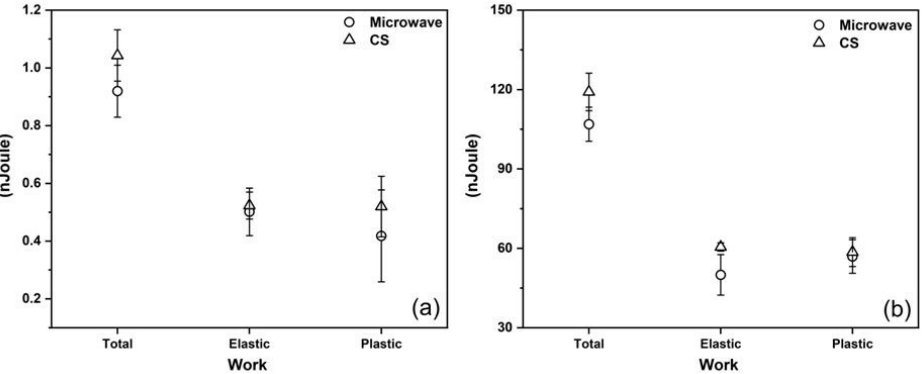
Figure 8. Total, elastic, and plastic works: maximum forces of ( a ) 1.0 gf/9.81 mN and ( b ) 20.0 gf/196.1